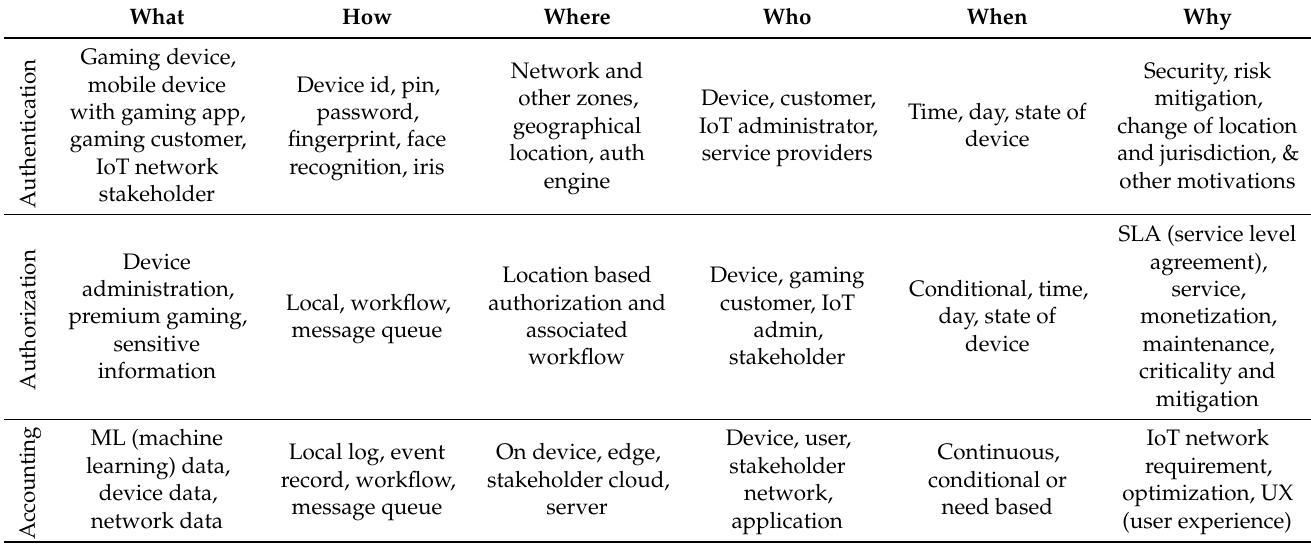
Table 1. Dynamic AAA requirements described using the Zachman